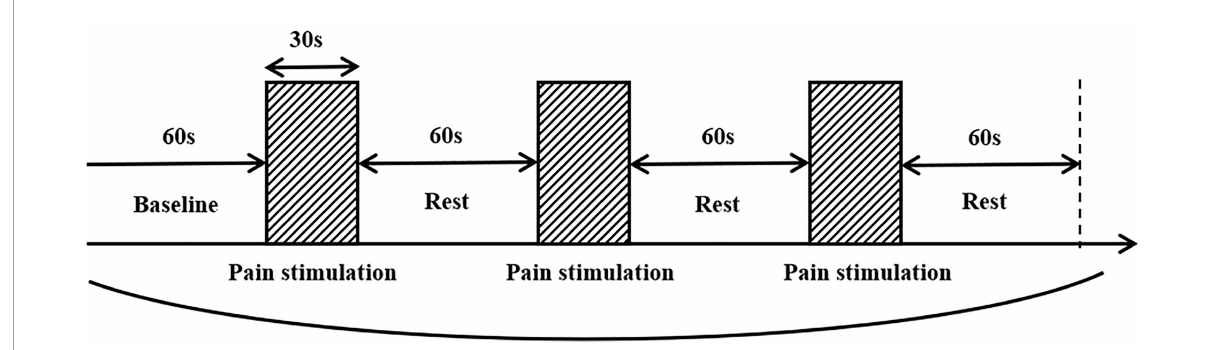
FIGURE1 Pain stimulation paradigm.